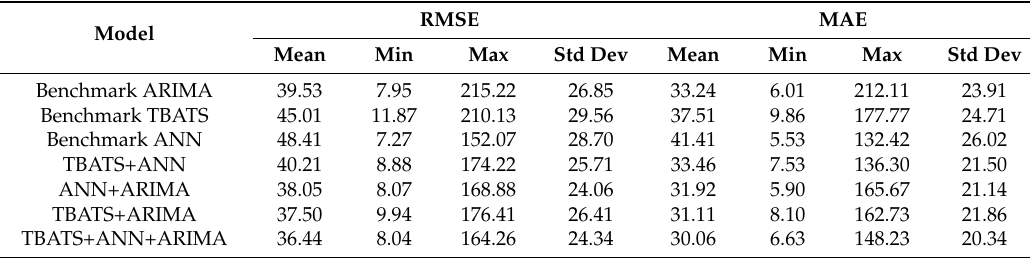
Table 7. Simple averaging